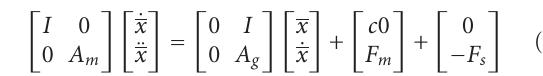
Figure 2: The four-degree-of-freedom